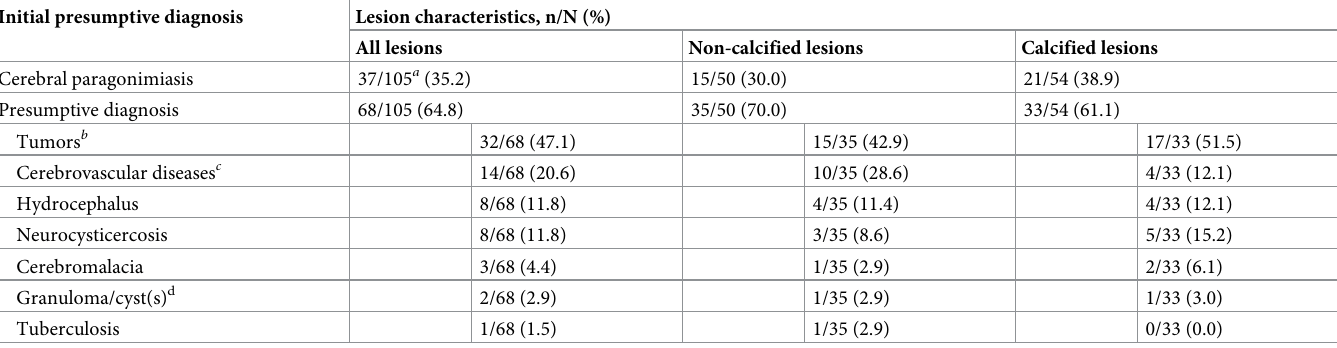
Table 1. Initial presumptive diagnosis of cerebral paragonimiasis patients enrolled in this